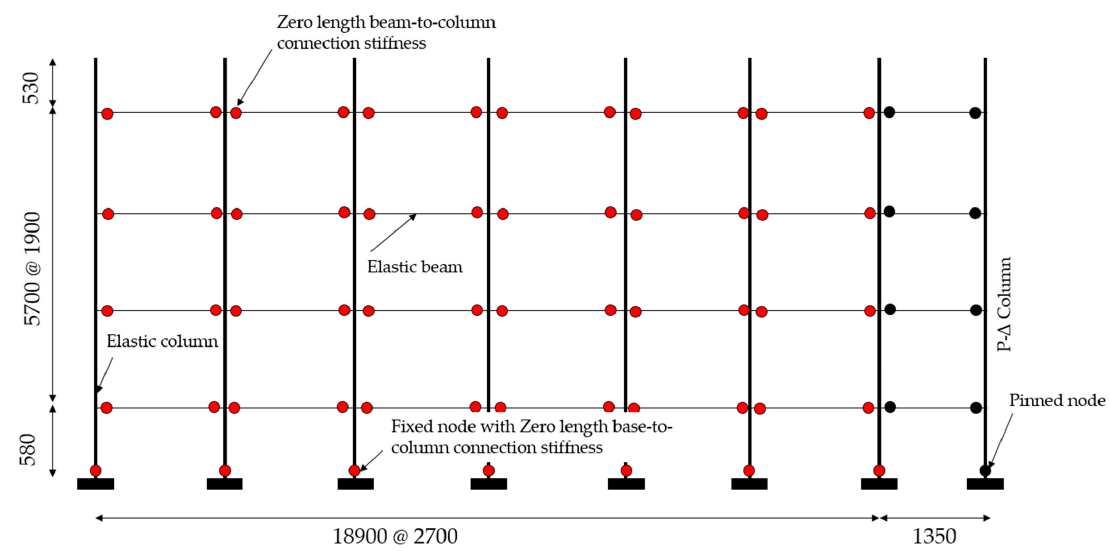
Figure 13. Mathematical Model developed in OpenSees (units in mm).